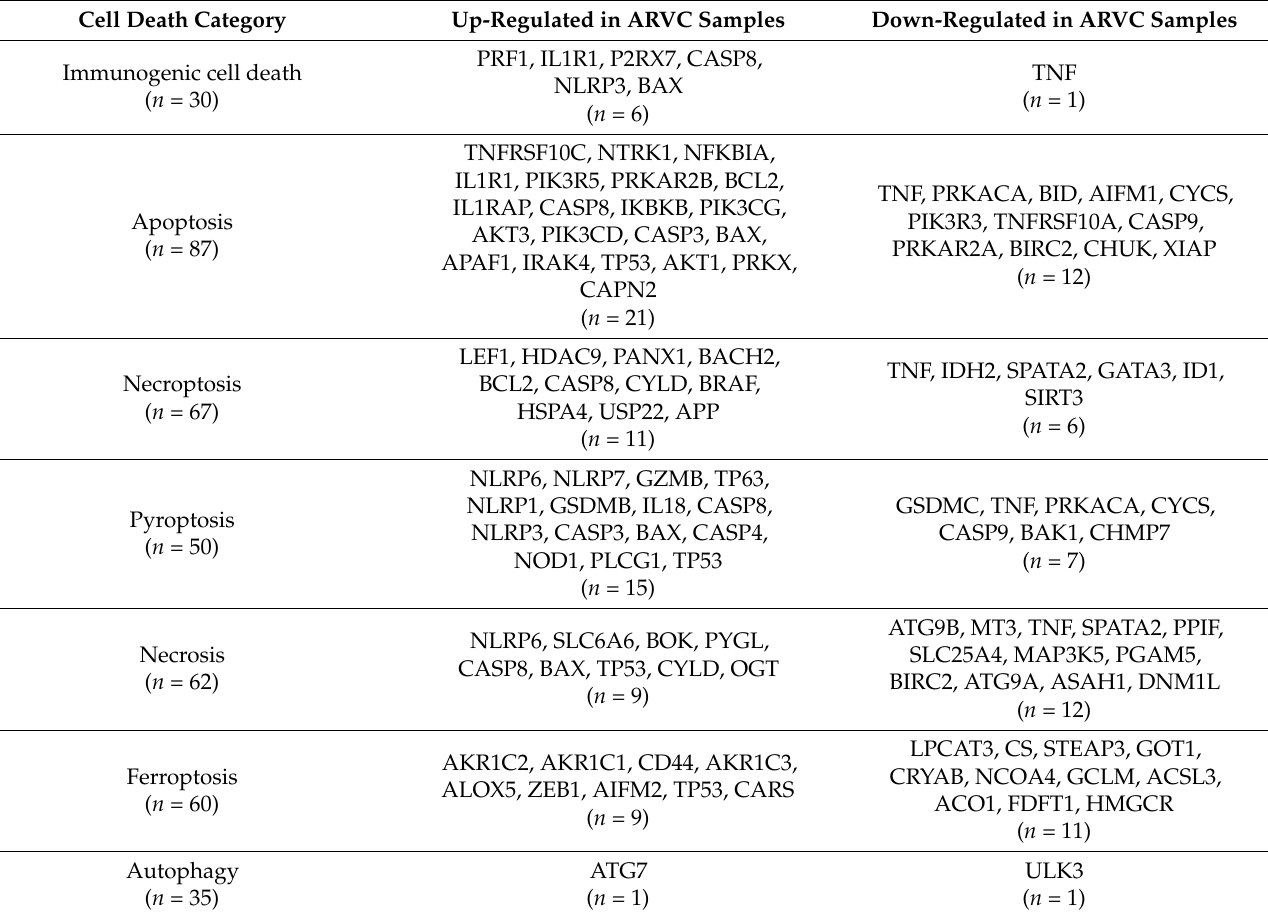
Table 1. Differentially expressed cell death signature